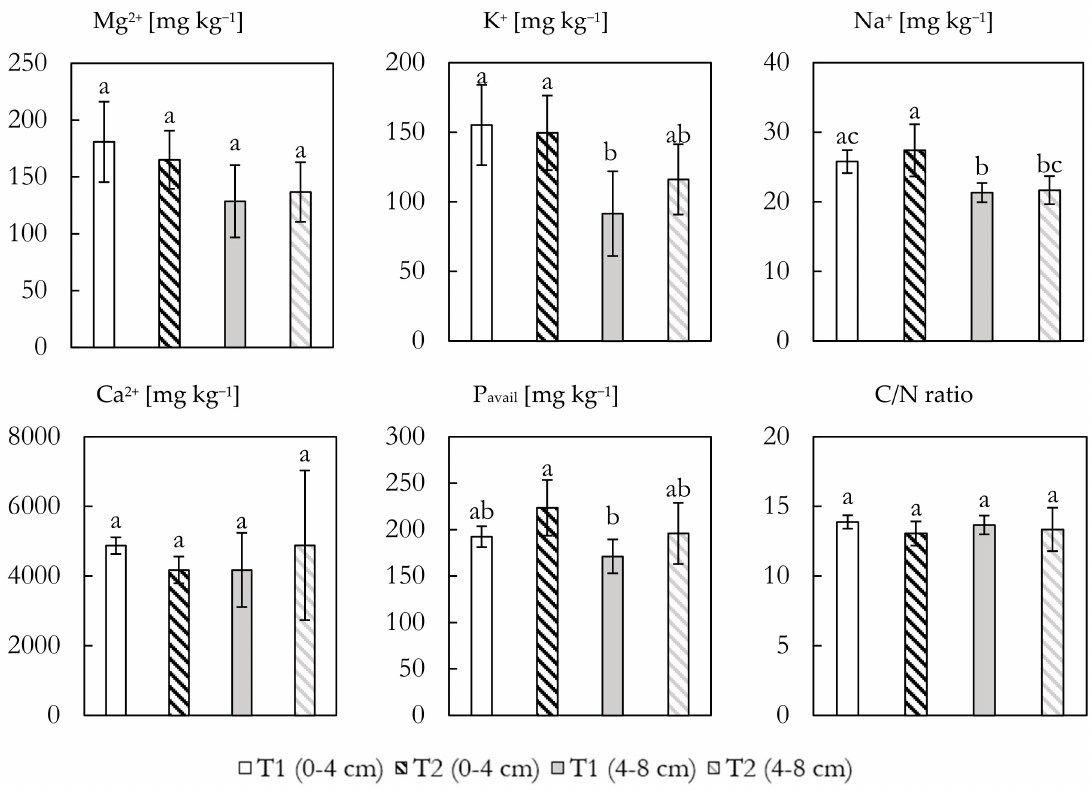
Figure 5. Concentrations of exchangeable ions and C / N ratio for the soil of T1 and T2 at two depths (n = 5). Standard deviation is shown with the error bars. Di ff erent letters refer to significance variations ( p < 0.05). T1 refers to the control